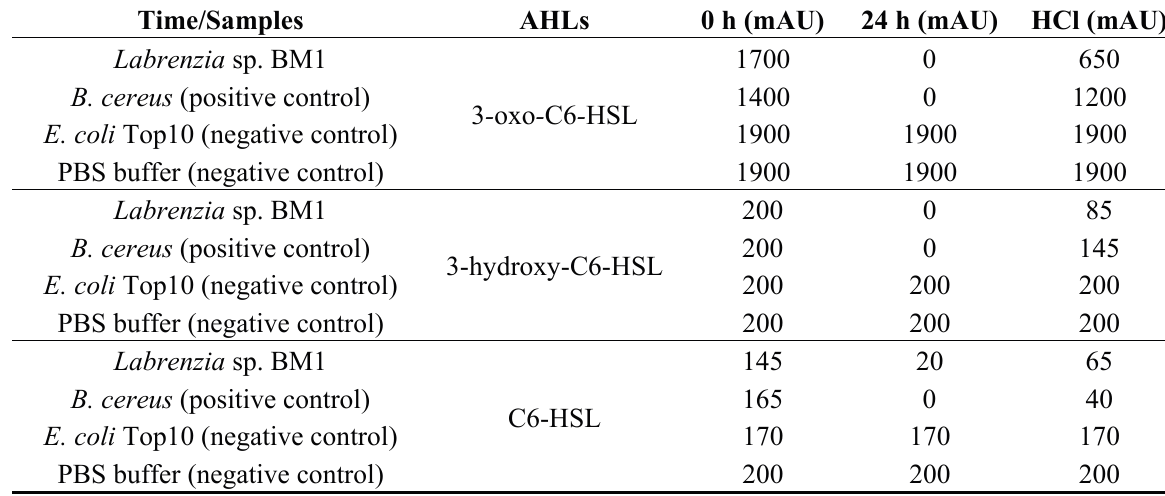
Table 2. Summary of AHLs degradation analysed using Rapid Resolution Liquid Chromatography